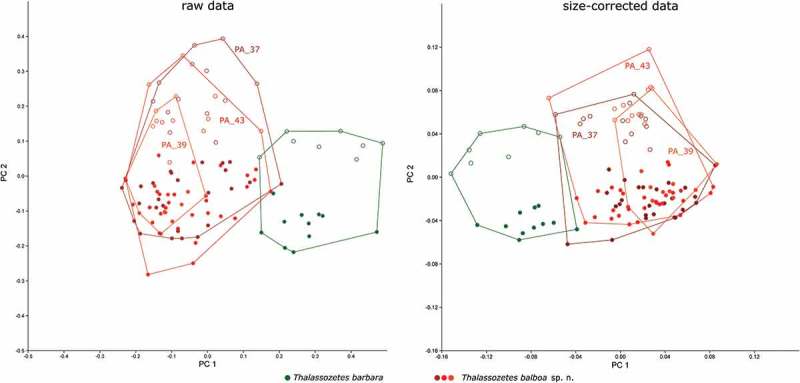
Scatter plots of PCA of T. barbara from Barbados and T. balboa sp. nov. from three different locations in Panama. Codes refer to sample sites given in the Materials and Method section; open symbols refer to females; filled symbols refer to male specimens.